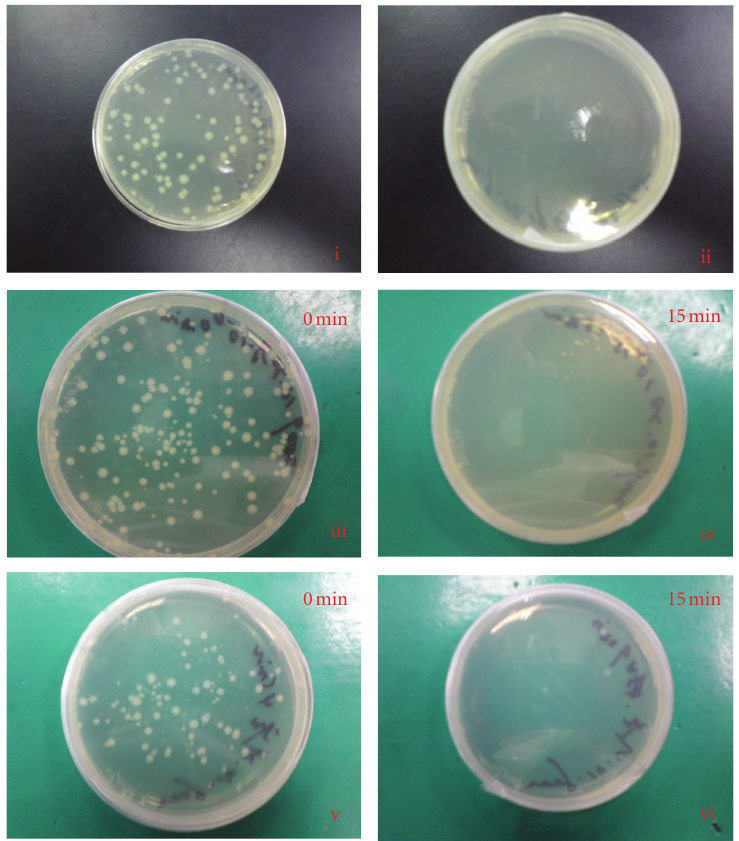
Figure 8: Inactivation e ff ect of E. coli by irradiation of di ff erent light sources (UV (i) (0min.) and (ii) (15min.) and visible (iii) and (iv) and dark (v) and (vi)) using Ag-TiO 2 as